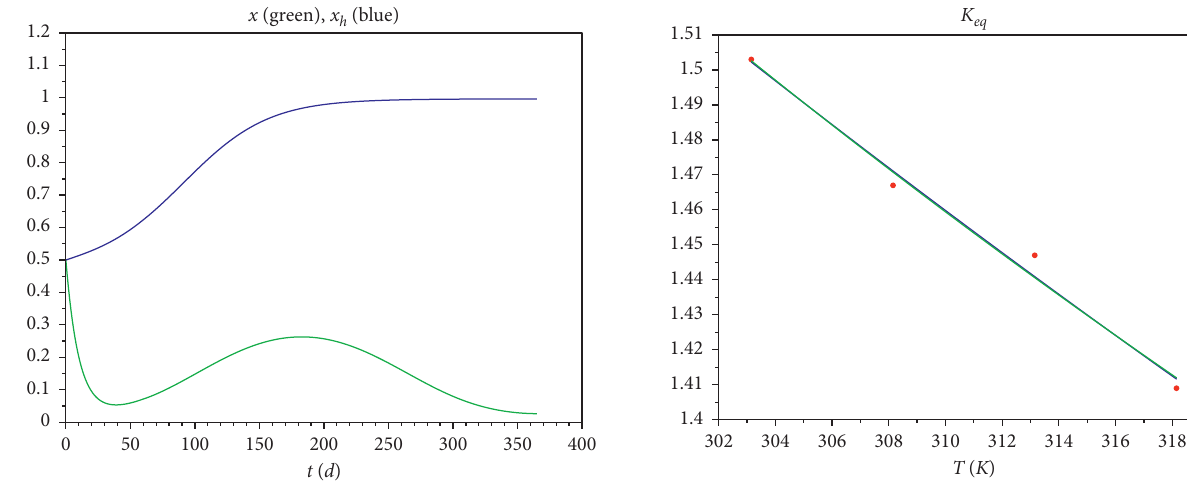
Figure 9: Plots of x ( t ) (green) and x ( t ) (blue) versus time. Figure 10: Plots of K eq versus temperature according to equation h (25) (green line) and (27) (blue